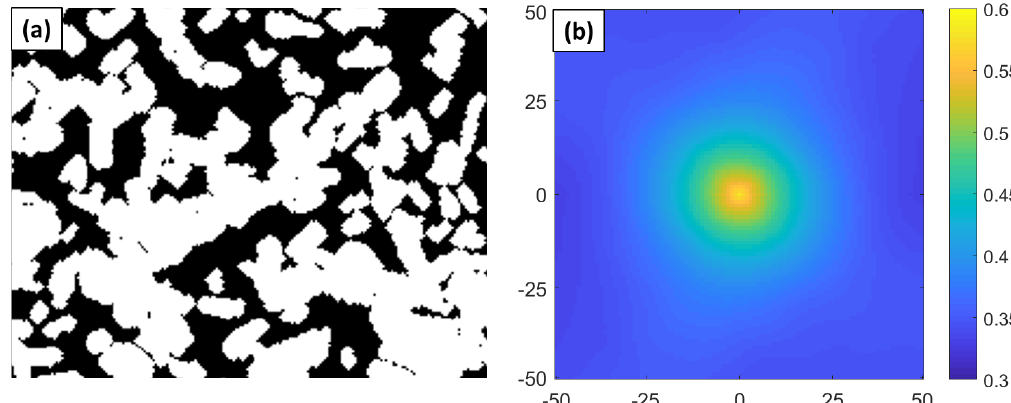
Figure 12. ( a ) Segmented version of a microstructural image acquired via scanning electron microscope. ( b ) Corresponding autocorrelation (trimmed to show short range vectors) of the segmented microstructure.